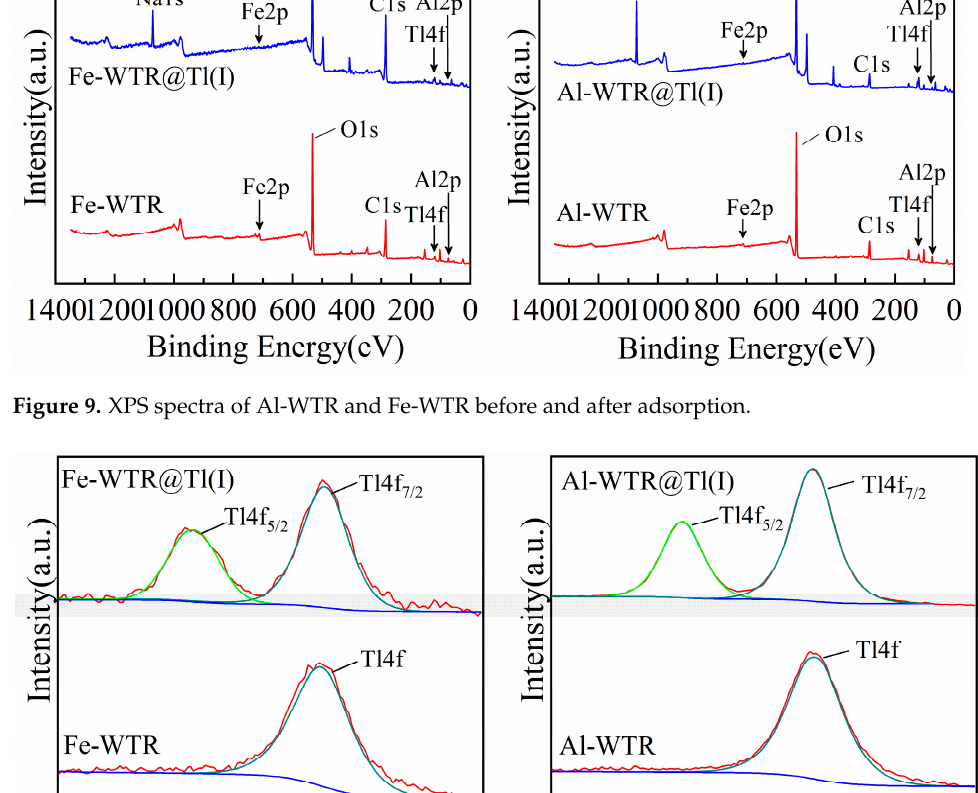
Figure 8. FTIR spectra of Fe-WTR and Al-WTR before and after adsorption.